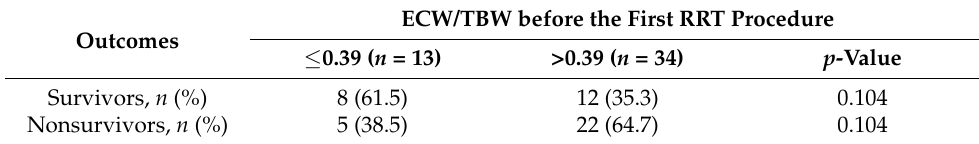
Table 3. The outcomes of the patients in different groups according to CVP. Table 4. The outcomes of the patients in different extracellular water to total body water (ECW/ TBW)